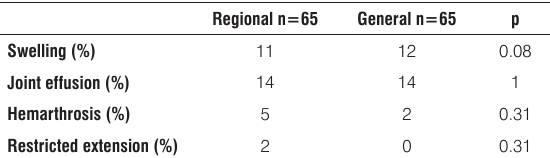
Table 4. Results of follow-up examination on Day 2 after surgery.